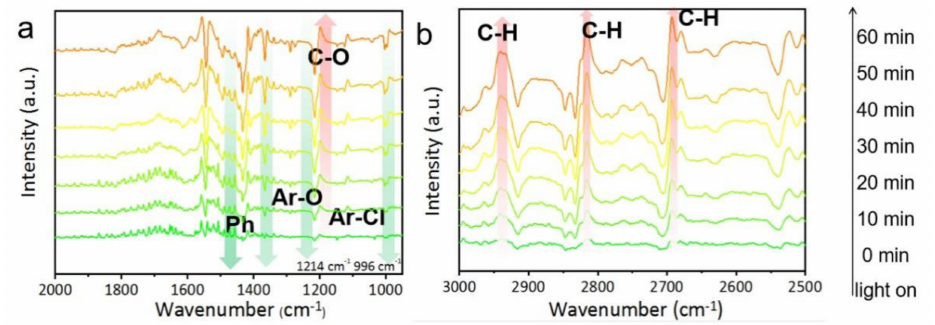
Figure 7. In situ DRIFTS spectra of photocatalytic NaPCP degradation in the range of 2000–1000 cm − 1 ( a ) and 3000–2500 cm − 1 ( b ) with BMO-001-300 under